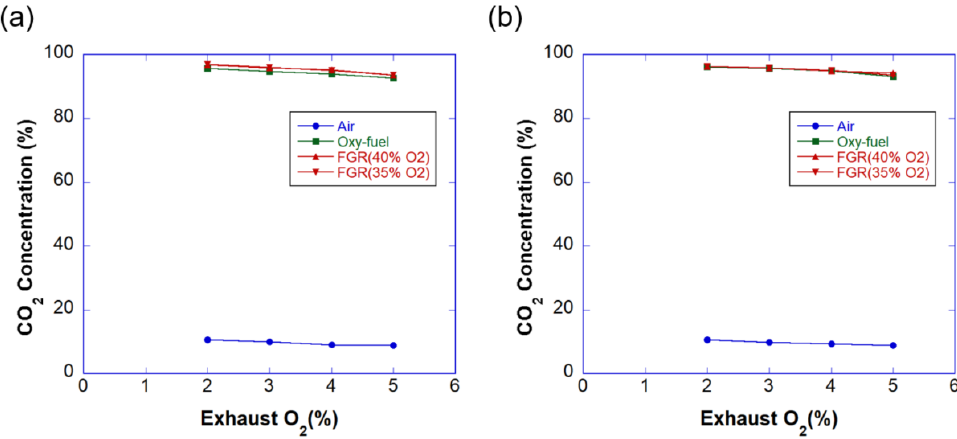
Figure 11. CO 2 concentration in the exhaust gas at ( a ) 100% and ( b ) 50% loads. CO decreased when the supply of the oxidizer was sufficient, and it converged to a very low value in all combustion modes when the exhaust O 2 exceeded 3.5% (Figure 12).